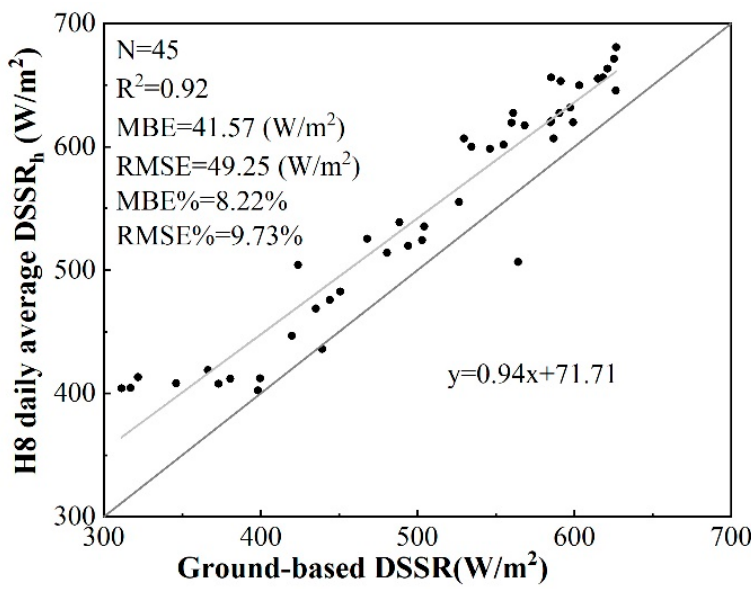
Figure 4. Scatterplots of the downscaled daily average DSSR vs. the corresponding ground-based measurements in the UM-HRB.